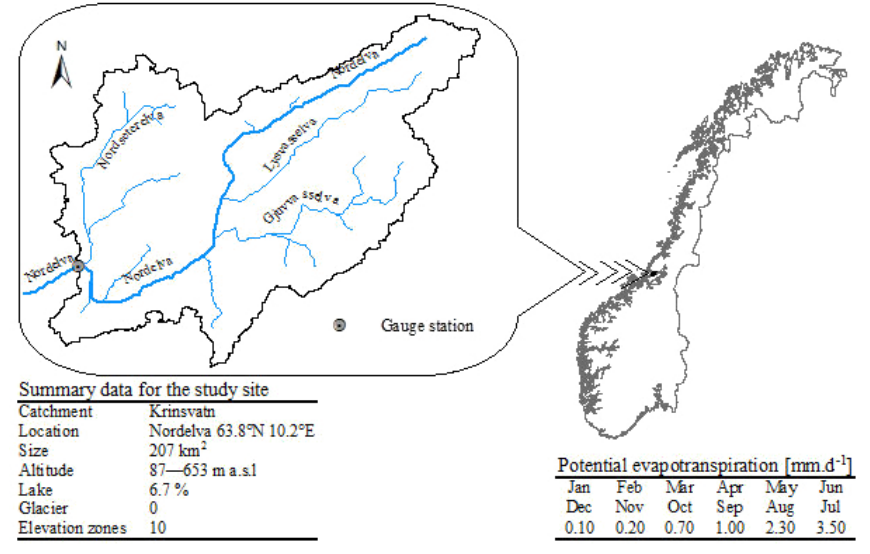
Figure 1. Location, characteristics and potential evapotranspiration estimates of the study catchment.